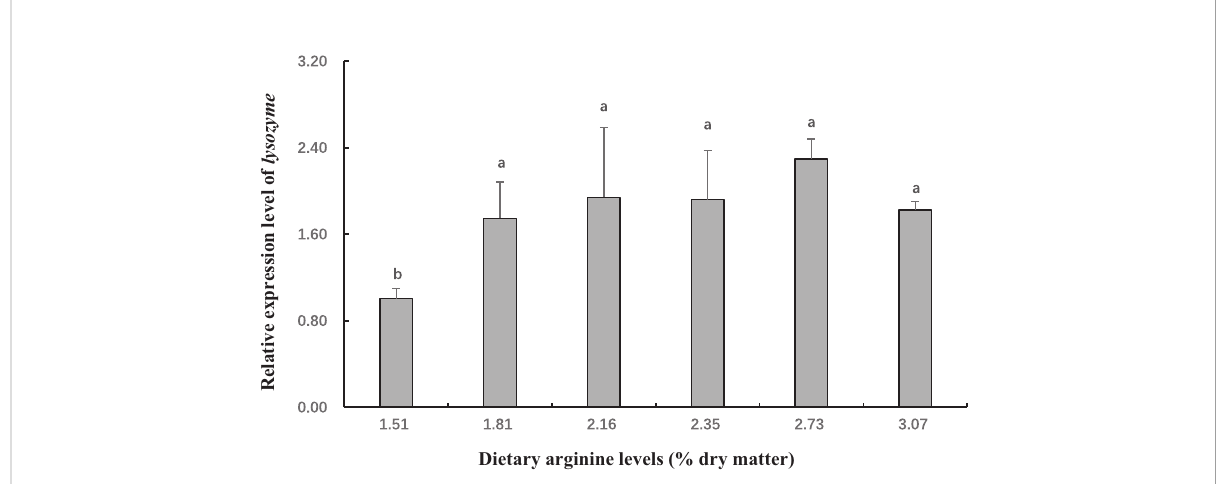
FIGURE 8 The gene expression ( lysozyme in hepatopancreas) of postlarval Scylla paramamosain fed diet with different arginine levels. Means in the same row with different superscripts are signi fi cantly different (P<